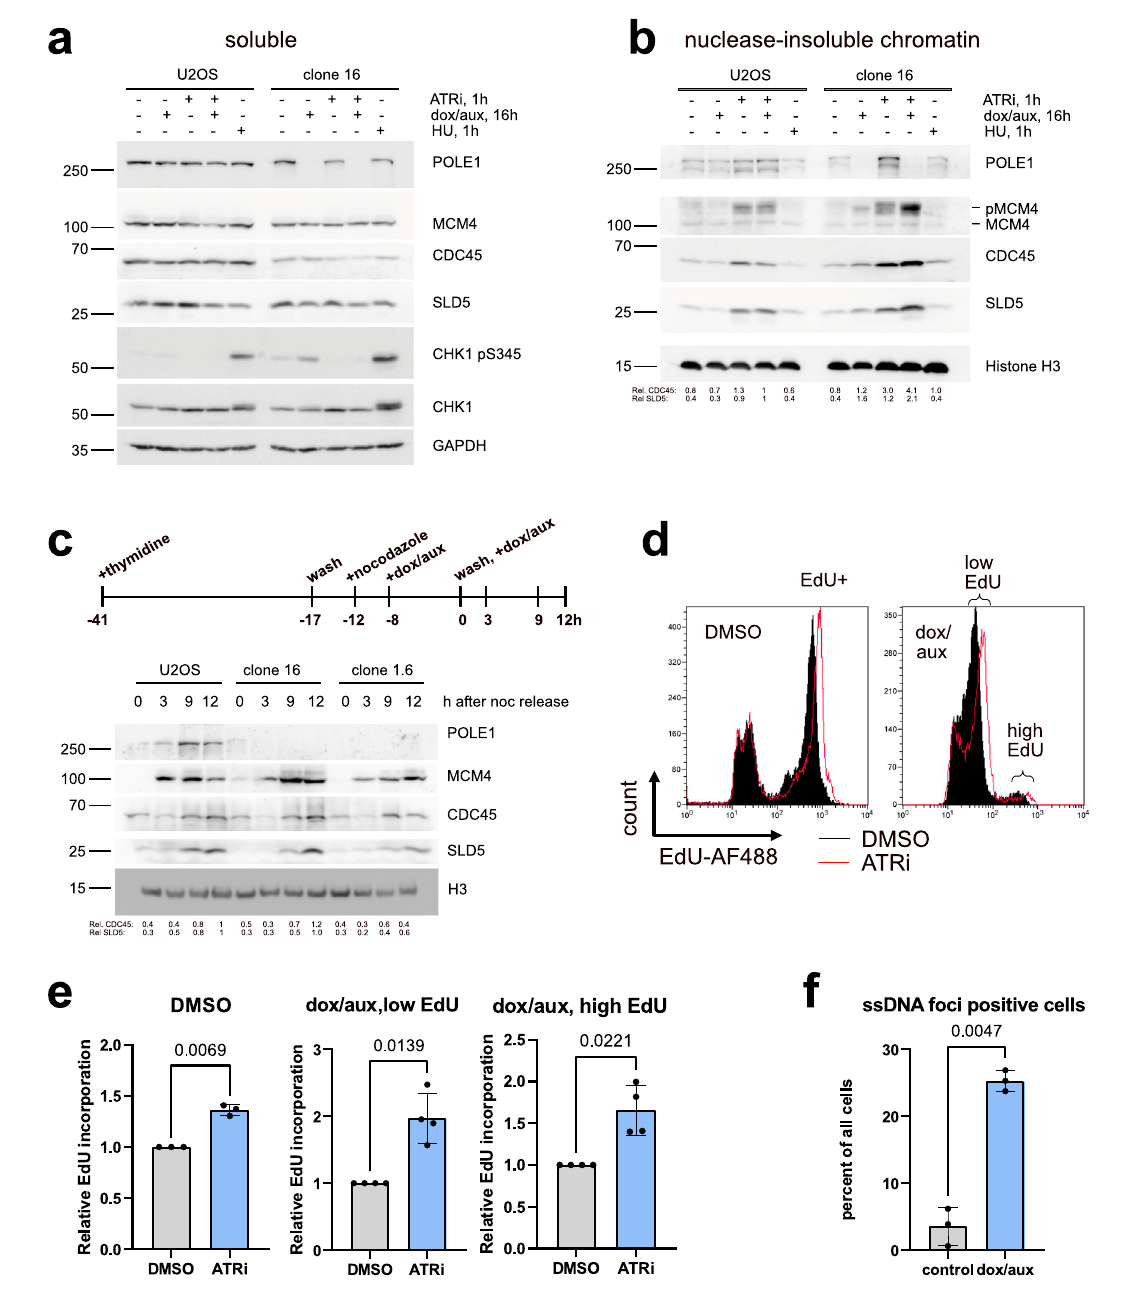
d , e Clone 16 cellsweretreated for 16h withDMSOordox/auxasindicated,DMSO or 5 µ M ATRi was added to the indicated samples for 60min before harvest, 10 µ M EdUwasaddedforthelast30minoftreatment.FlowcytometryplotsshowingEdU incorporation histograms ( c ) and relative EdU incorporation, normalized to the samples without ATRi, are shown ( d ) — mean+SD from n =3 (DMSO) or n =4 (dox/ aux) independent experiments. Paired t-test was used for statistical analyses, p values are shown. f Clone 16 cells were incubated with 10 µ M CldU for 48h, DMSO or dox/aux were added for the last 16h of treatment. After CSK extraction, cells were fi xed and stained with anti-CldU antibodies under native conditions. Quanti- fi cation of ssDNA-positive cells is shown — mean+SD from n =3 independent experiments.Pairedt-testwasusedforstatisticalanalyses, p valueisshown.Source data are provided as a Source data fi le.